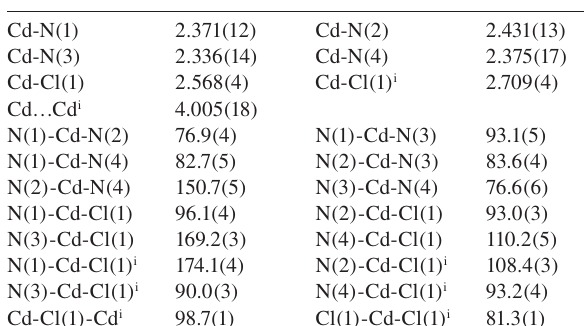
Table 1 Selected bond distances ( Å ) and angles ( ° ) for [Cd(L)